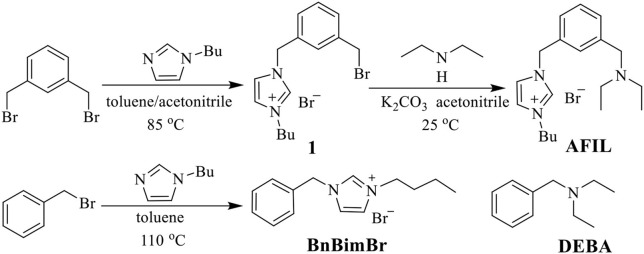
The structures of catalysts for the cycloaddition of CO2 and epichlorohydrin.